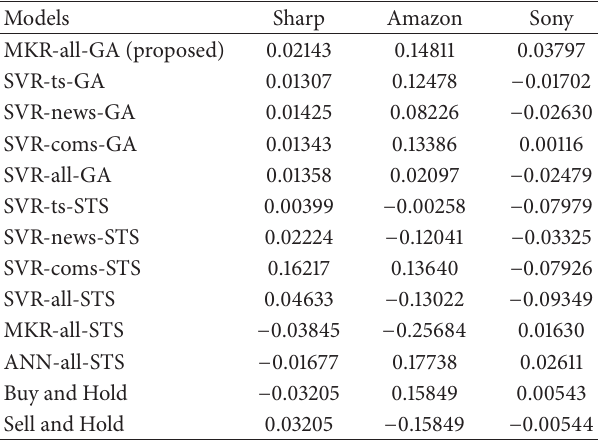
Table 13: Average returns in the five out-of-sample testing periods (of four months each) in the ratio of the initial investment.